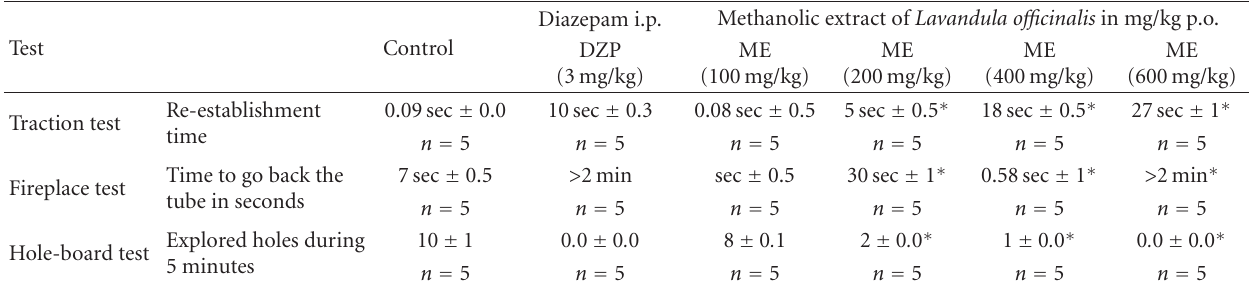
Table 1: Sedative action of Lavandula o ffi cinalis methanolic extract. p.o. means oral route; i.p. means intraperitoneal route; n means number of mice per group; sec means seconds; ME: mean methanolic extract; DZP means diazepam. Data are expressed as mean ± SD; P < 0 . 001 versus the control group.